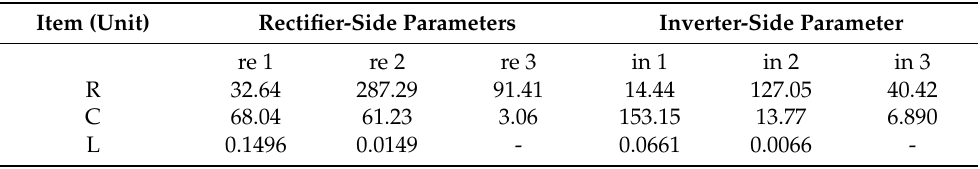
Table 2. Parameters of AC filters.